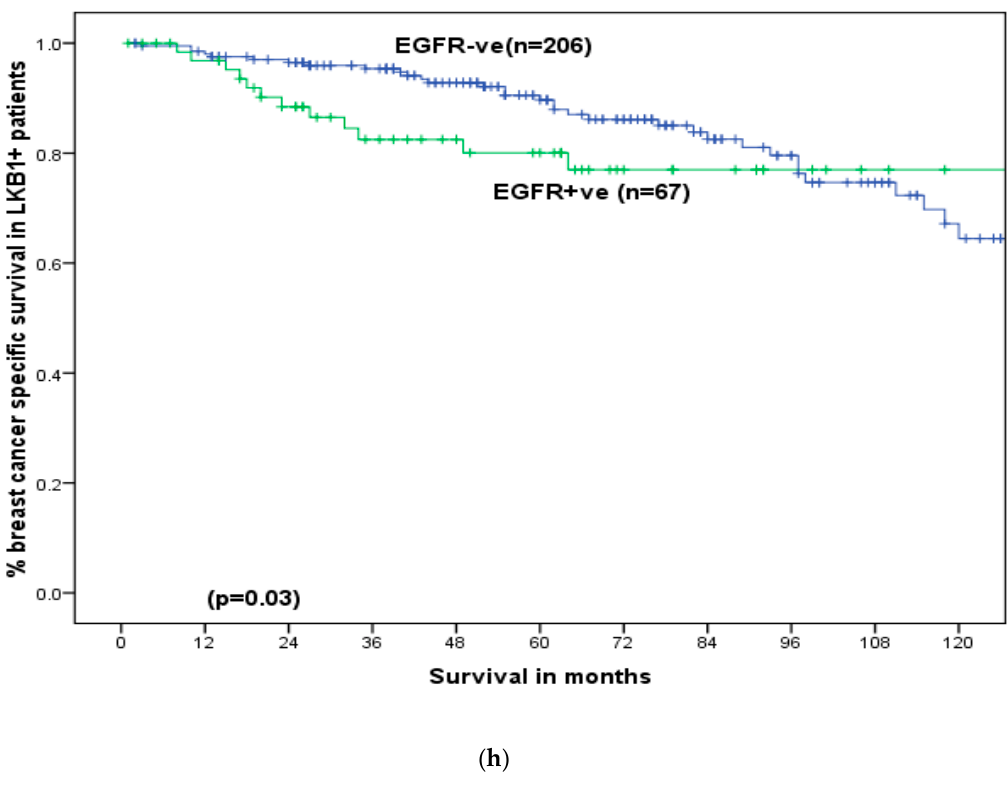
Figure 4. Breast cancer specific survival in LKB1 positive early operable primary breast cancer in older women: ( a ) Oestrogen receptor positive versus oestrogen receptor negative. ( b ) Progesterone receptor(PgR) positive versus Progesterone Receptor negative, ( c ) Mucin (MUC)-1 positive versus Mucin 1 negative, ( d ) B-Cell Lymphoma-2 (Bcl2) positive versus B-Cell Lymphoma 2 negative, ( e ) Human Epidermal Growth Factor Receptor-2(HER2) positive versus Human Epidermal Growth Factor Receptor-2 negative, ( f ) Ki67 positive versus Ki67 negative, ( g ) Cytokeratin 17(CK17) positive versus Cytokeratin 17 negative, ( h ) Epidermal Growth Factor Receptor (EGFR) positive versus Epidermal Growth Factor Receptor negative.